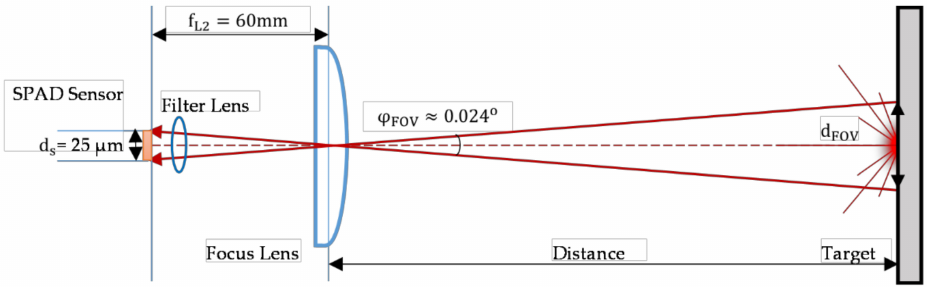
Figure 3. Detector field of